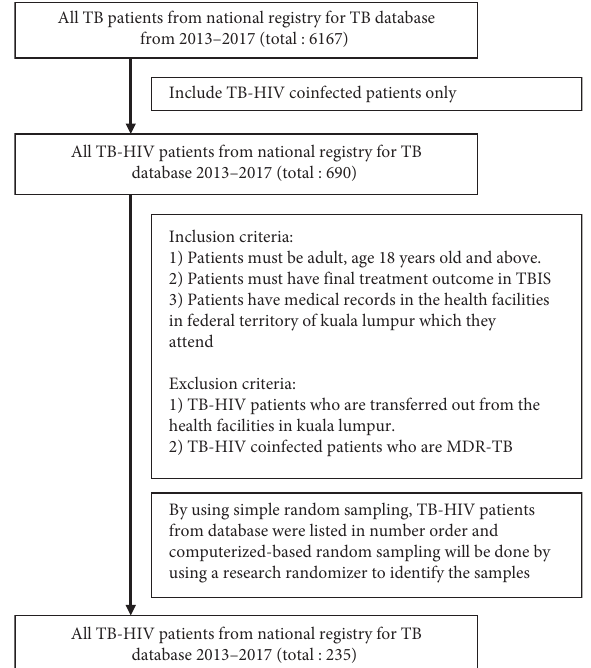
Figure 1: The recruitment of TB-HIV patients for this